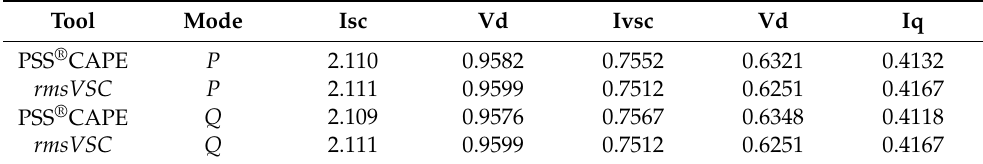
Table 2. Comparative results for case 2 (60 MW/40